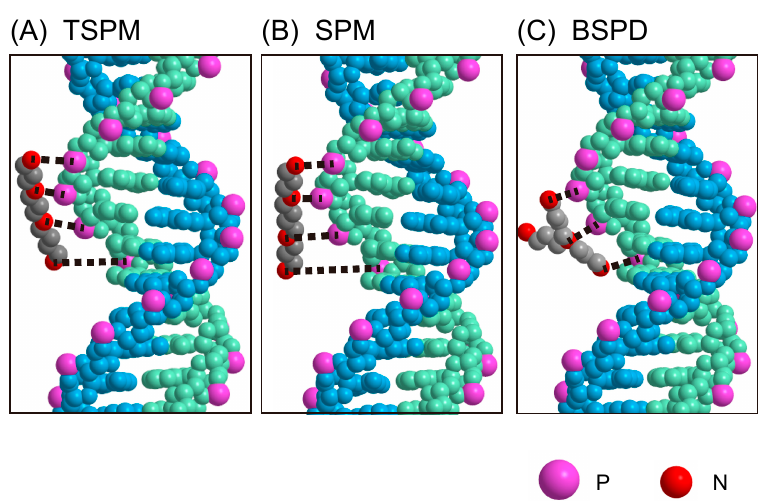
Figure 6. The most stable spatial arrangement of the polyamines interacting with double-stranded DNA, evaluated through a numerical simulation under a simple model in the framework of electrostatic interaction (see the main text). Electrostatic interaction mode was evaluated as the attractive interaction between the negatively charged phosphate groups of DNA and positively charged polyamines. The phosphate groups of DNA are indicated by purple beads, and the amino groups of polyamines are indicated by red beads. The adjacent pairs of negatively charged moieties in the DNA model are separated by 0.34 nm.